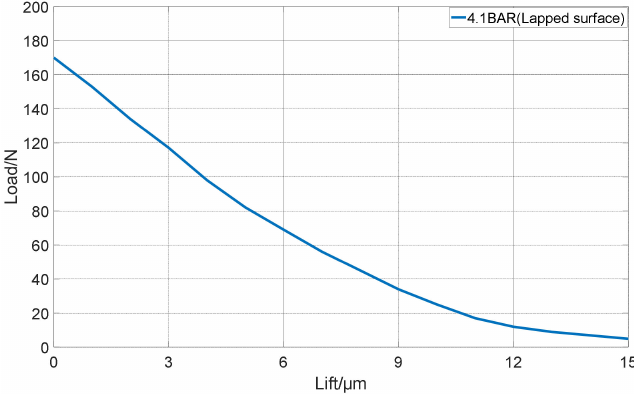
Figure 3. Relations between load and lift for a Ø25 mm pad.